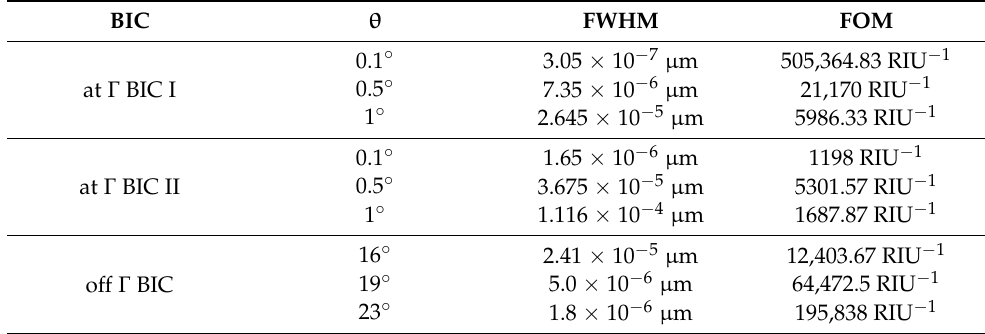
Table 2. FOM for different BICs at different incidence